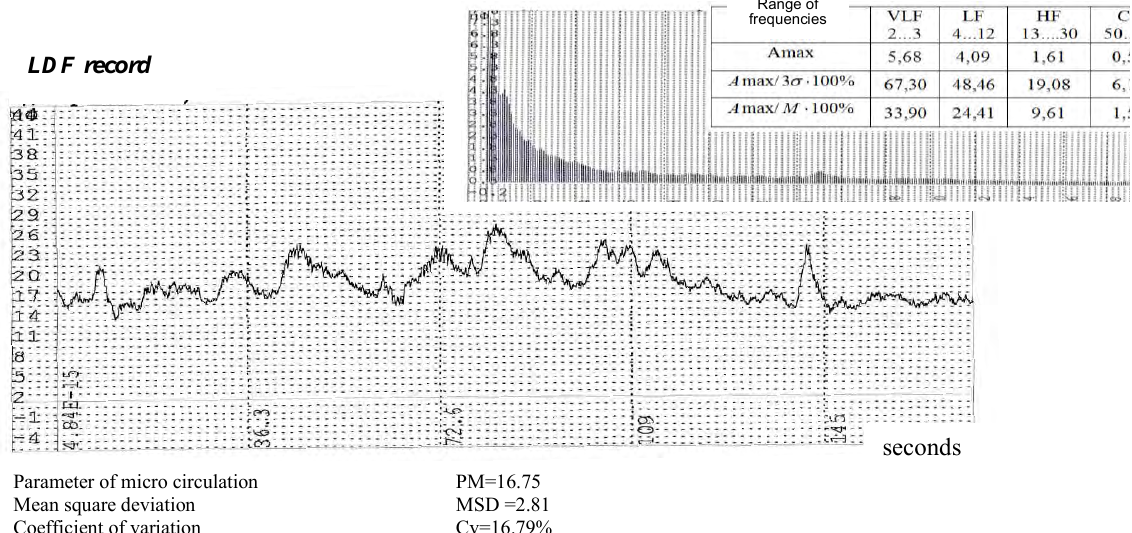
Fig.2. Daily monitoring of LDF record of 17 years old girl with standard type of micro-circulation at 12